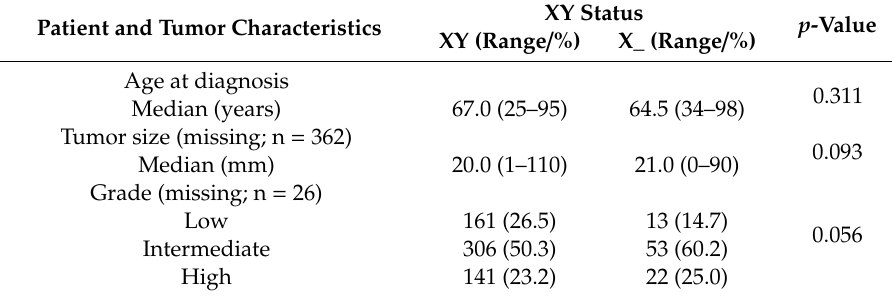
Table 2. Association of loss of Y-chromosome (LOY) with male breast cancer (BC) clinicopathological characteristics (n =